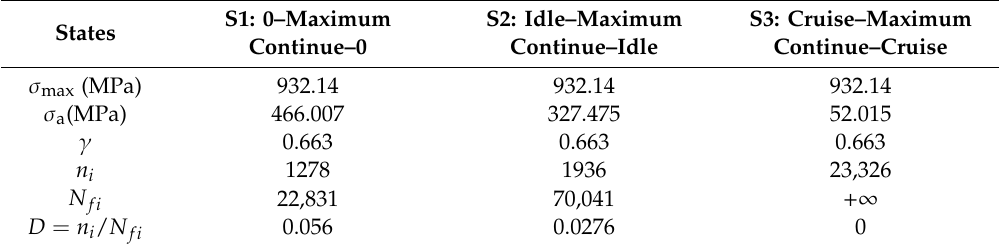
Table 3. Field loading spectrum and fatigue damage of high pressure turbine disc in 750